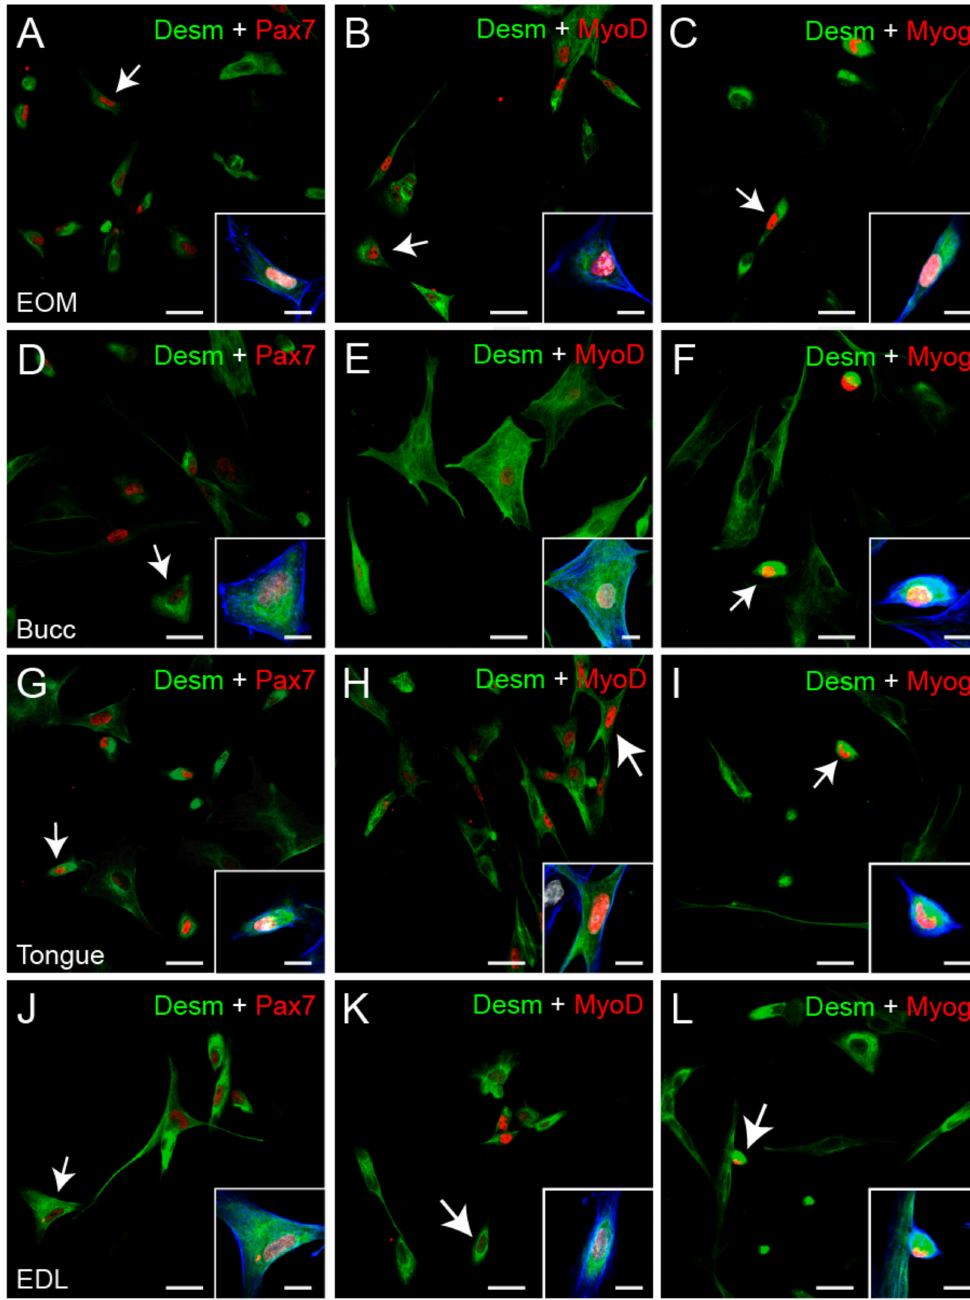
Figure 1. Myogenicity of the cultured cells. Confocal images showing cultured cells obtained from each type of muscle and immunostained for the myogenic markers (Pax7, MyoD and Myogenin (Myog): red, and desmin (Desm): green, as indicated on each image). Insets show a magnified image of the cell indicated by the white arrow on each case. In these images, the cytoplasm is marked with phalloidin (blue) and the nucleus with DAPI (white). Images ( A – C ), ( D – F ), ( G – I ) and ( J – L ) correspond to cells obtained from EOM, buccinator (Bucc), tongue and EDL, respectively. Arrows indicate cells immunopositivity for two markers. Scale bars: A to L: 25 µ m, inset on each image: 10 µ m. + + When the percentage of Pax7 and MyoD cells were compared, the EOMs showed 80.6% ± 3.8%, N = 24 and 33.2% ± 5.3, N = 24, respectively, while cultures derived from the tongue and the EDL showed a lower percentage of cells expressing Pax7; 67.0% ± 2.8%, N = 24 and 64.4% ± 3.2%, N =